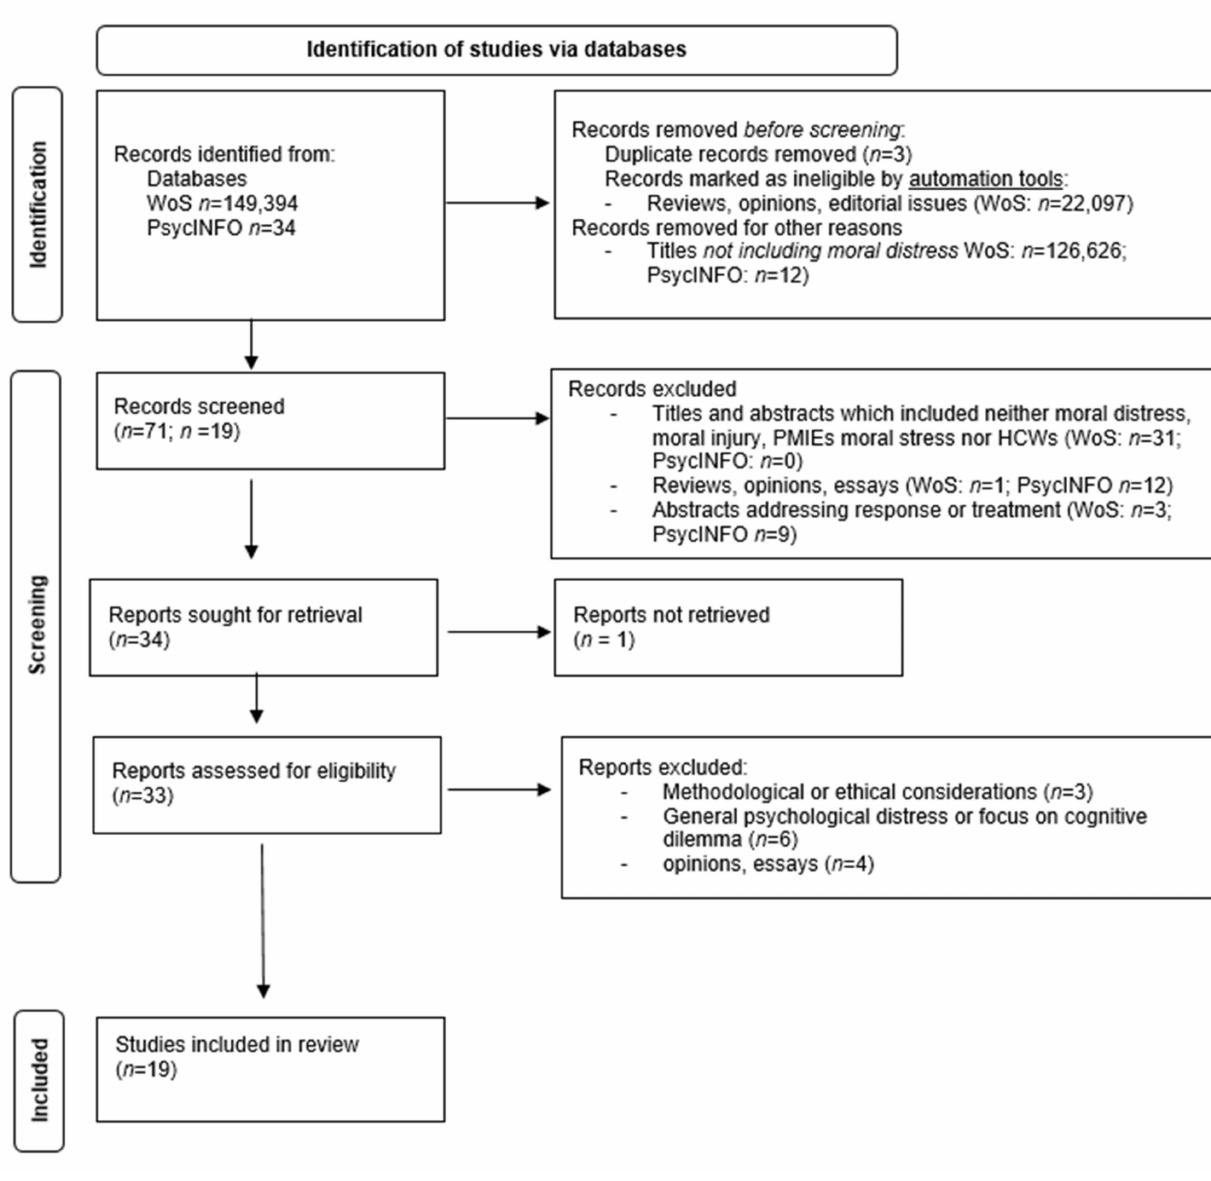
Figure 1. Study selection